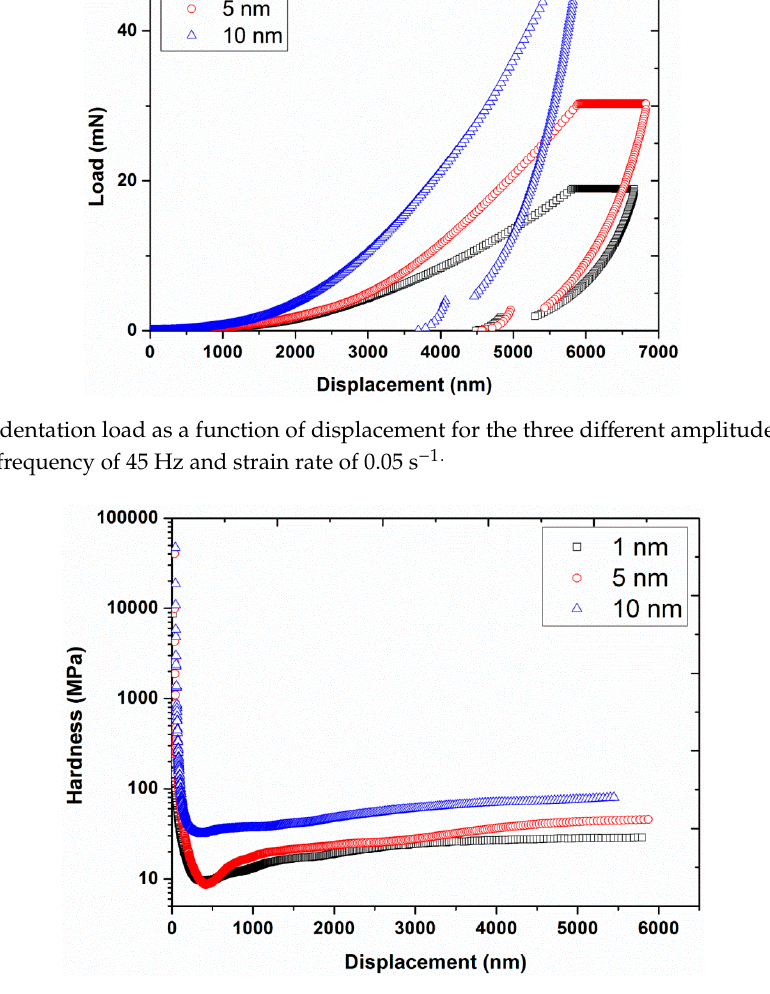
Figure 2. Hardness as a function of displacement for the three different amplitudes (1, 5, and 10 nm) at a frequency of 45 Hz and strain rate of 0.05 s − 1.